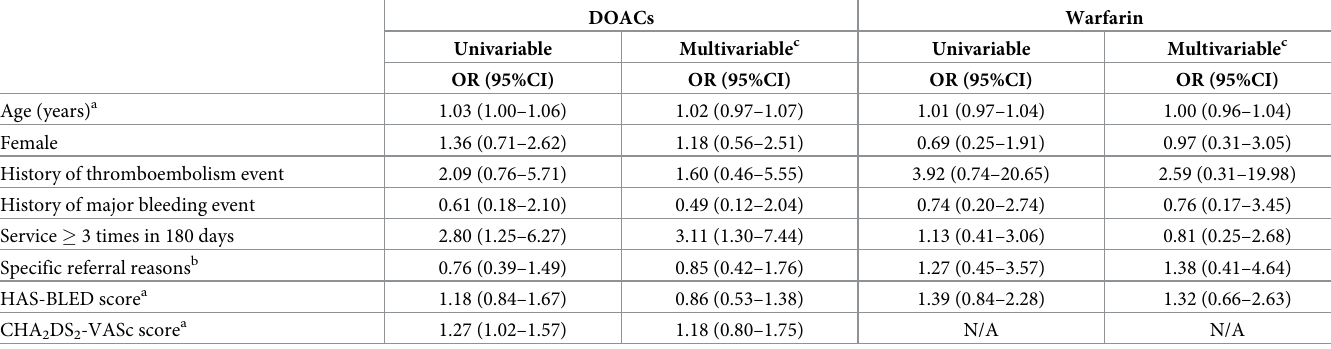
Table 3. Logistic regression analysis of the factors associated with the totally solved status of DRPs.